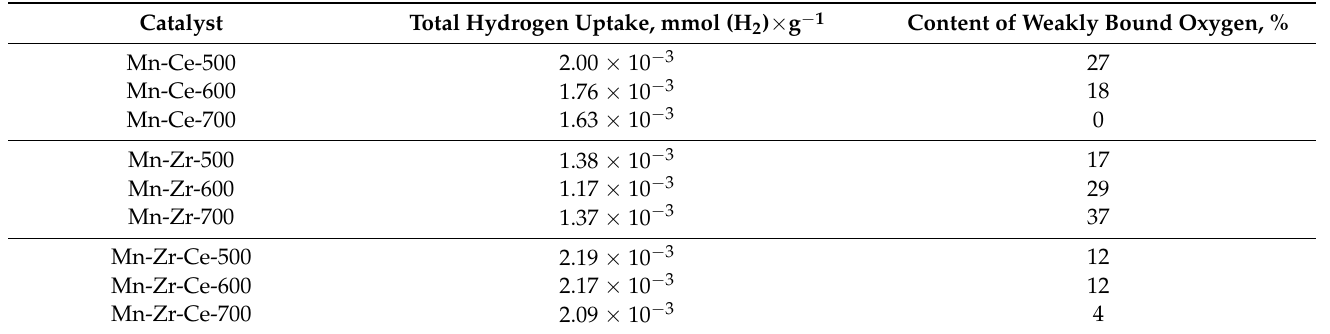
Table 2. TPR data for Mn-Ce, Mn-Zr and Mn-Zr-Ce catalysts, calcined at 500, 600 and 700 ◦ C.